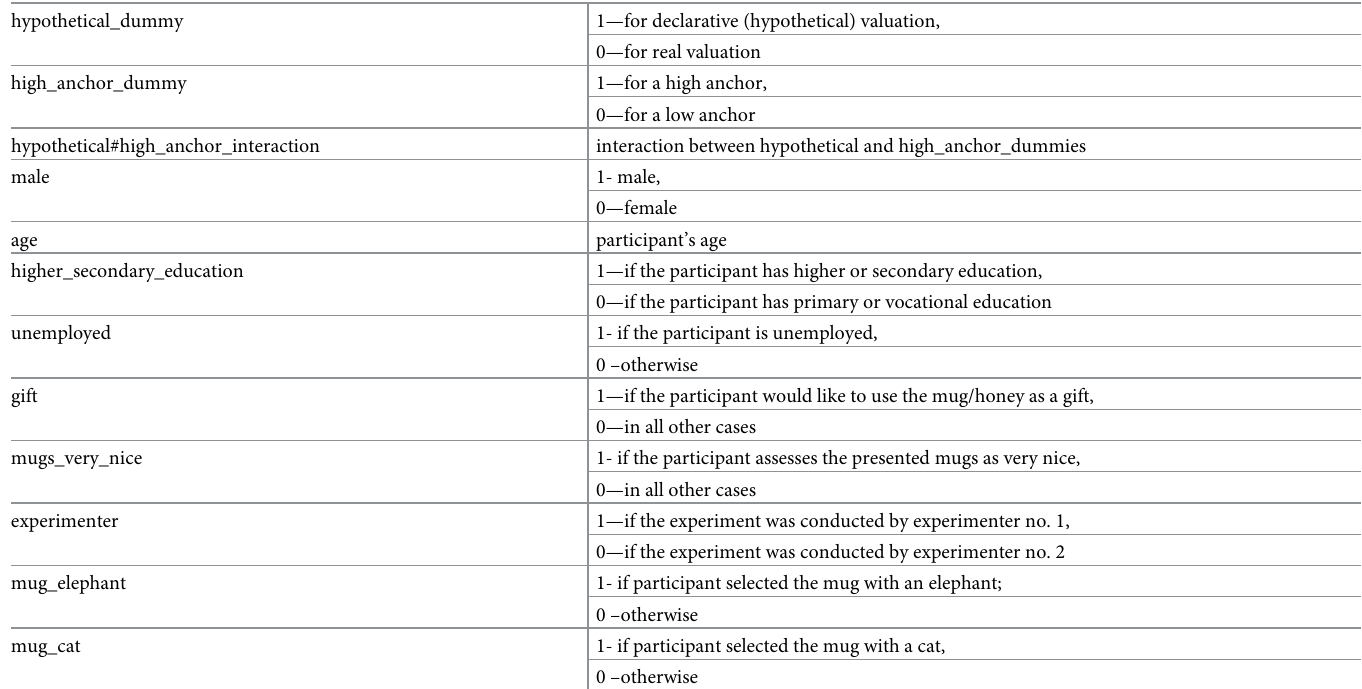
Table 8. Experiment 2: Variable labels.